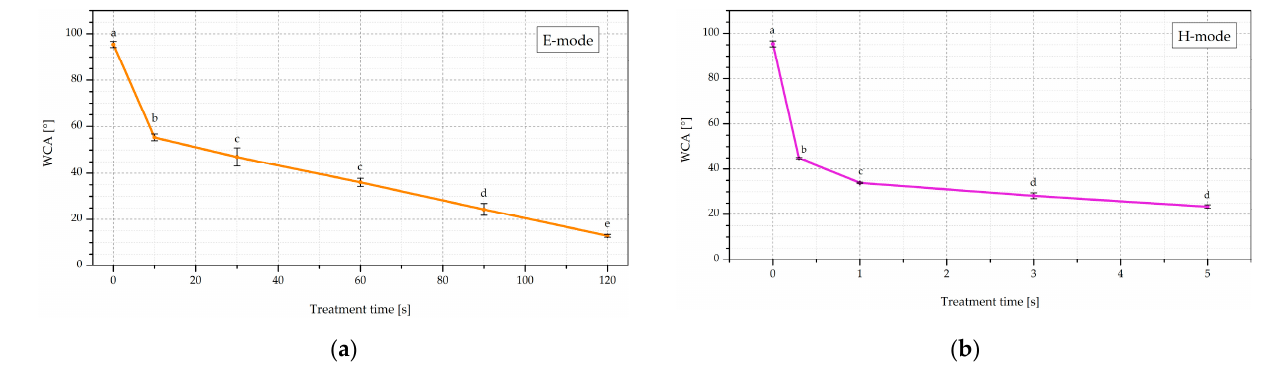
Figure 2. Water contact angle (WCA) on the alfalfa seed surface after treatment with an ( a ) E mode or ( b ) H-mode plasma at various treatment times. The error bars represent standard error. Different lowercase letters above data points represent statistically significant differences ( p < 0.05; post hoc Tukey’s range test) between